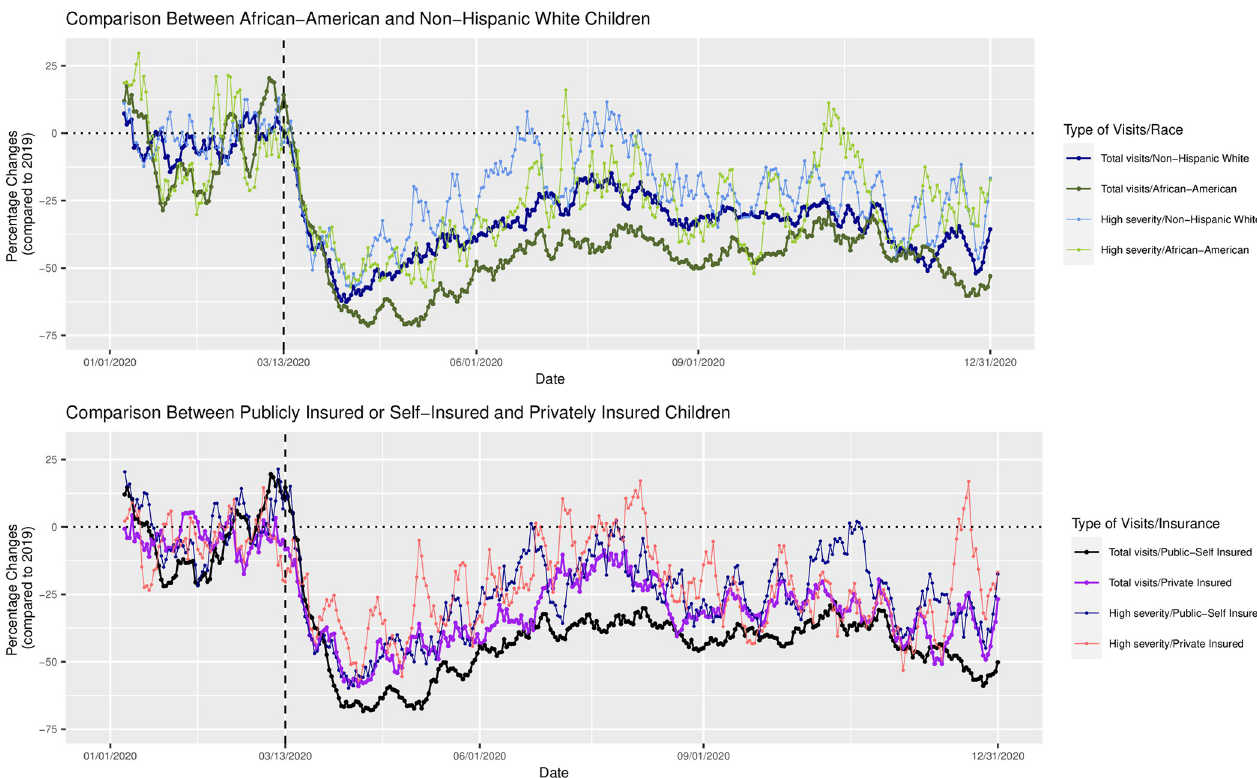
Fig 1. Date − specific percentage changes of 7 − day moving average on ED visits in total and high-severity ED visits in 2020 compared to 2019.